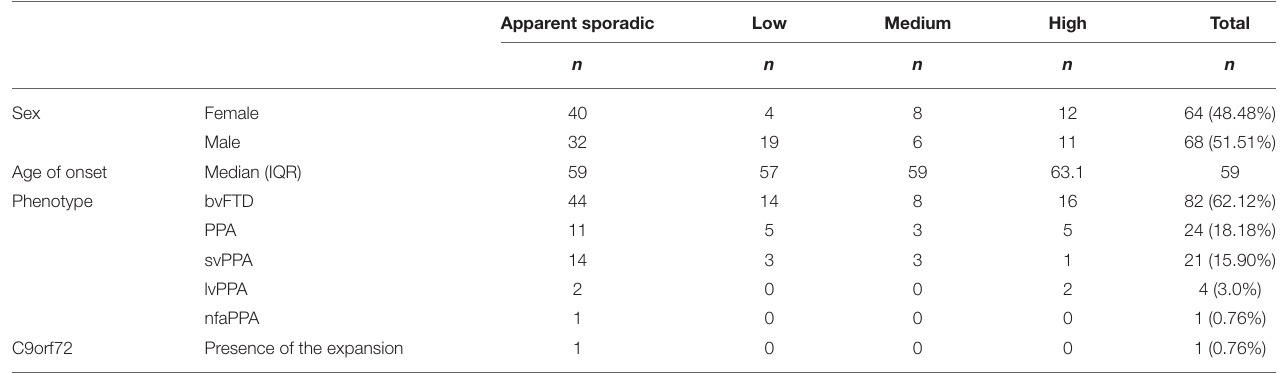
TABLE 1 | FTD spectrum disorder pedigree categorization according to sex, age of onset, phenotype, and C9orf72 genotype. Apparent